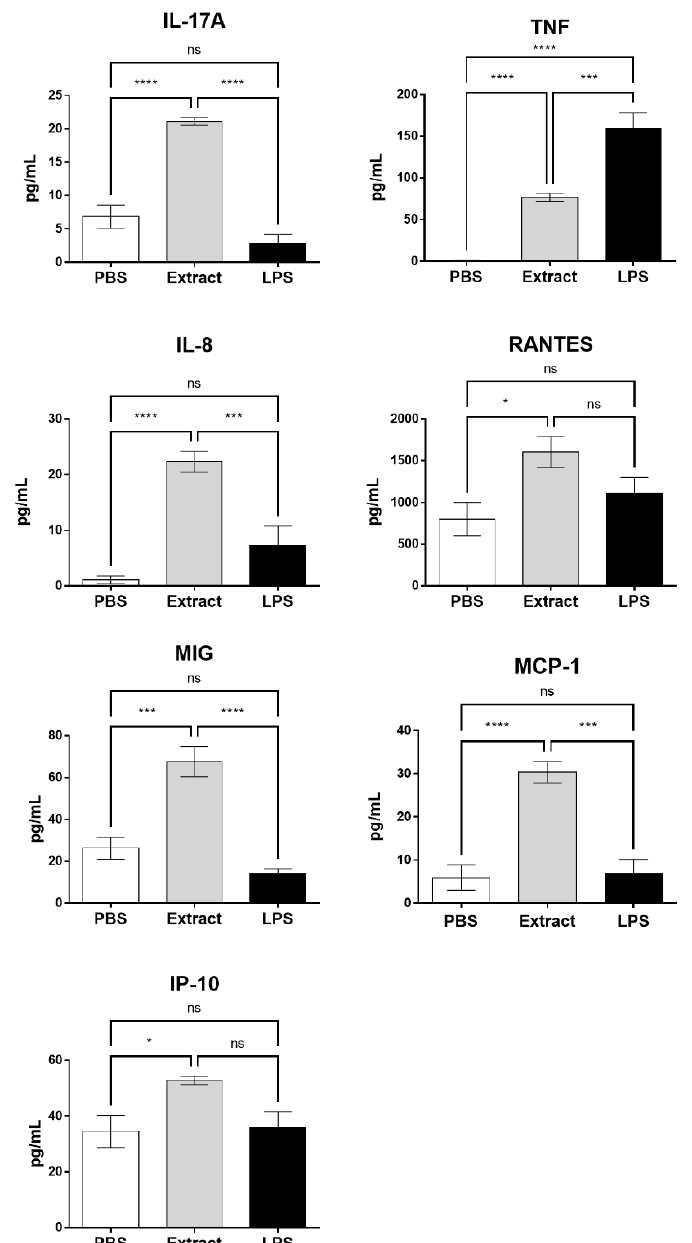
Figure 3. Cytokine and chemokine levels in whole blood stimulated with Pararama hair extract. Human blood samples anticoagulated with lepirudin (50 µg/mL) were incubated with Pararama hair extract (95 µg/mL), LPS (5 µg/mL), or PBS for 30 min at 37 °C. After plasma collection, the production of cytokines (IL-17A, TNF) and chemokines (IL-8, RANTES, MIG, MCP-1, and IP-10) was determined by flow cytometry. The results are presented as the mean ± SD of three independent experiments. * p : < 0.05. *** p : < 0.001. **** p : < 0.0001. ns: not significant.